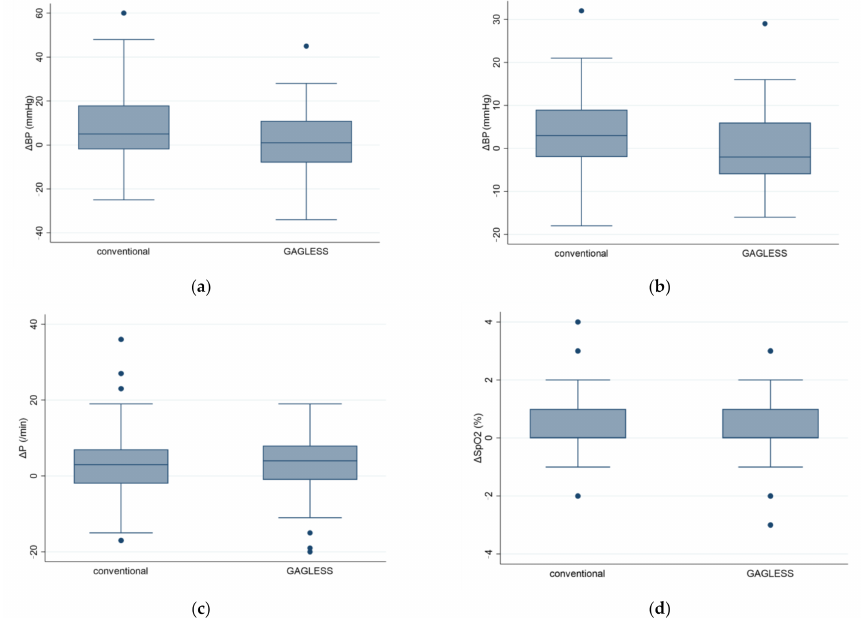
Figure 2. Cardiovascular responses in the GAGLESS group and the conventional group. Changes in ( a ) systolic blood pressure (SBP), ( b ) diastolic blood pressure (DBP), ( c ) pulse rate (PR), and ( d ) oxygen saturation by pulse oximetry (SpO2) were evaluated before and after scope insertion. Values represent means and standard errors of the mean. * p <